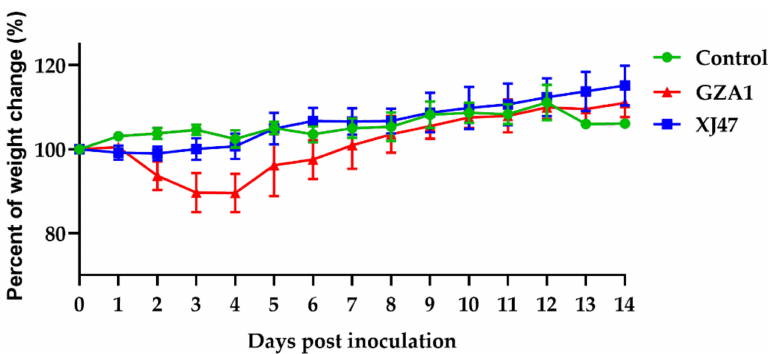
Figure 1. Daily weight changes of mice were recorded within 14 days after infection with the GZA1 and XJ47 strains. Values represent the mean percentage ± standard deviation (SD) relative to the original body weight of the mice.